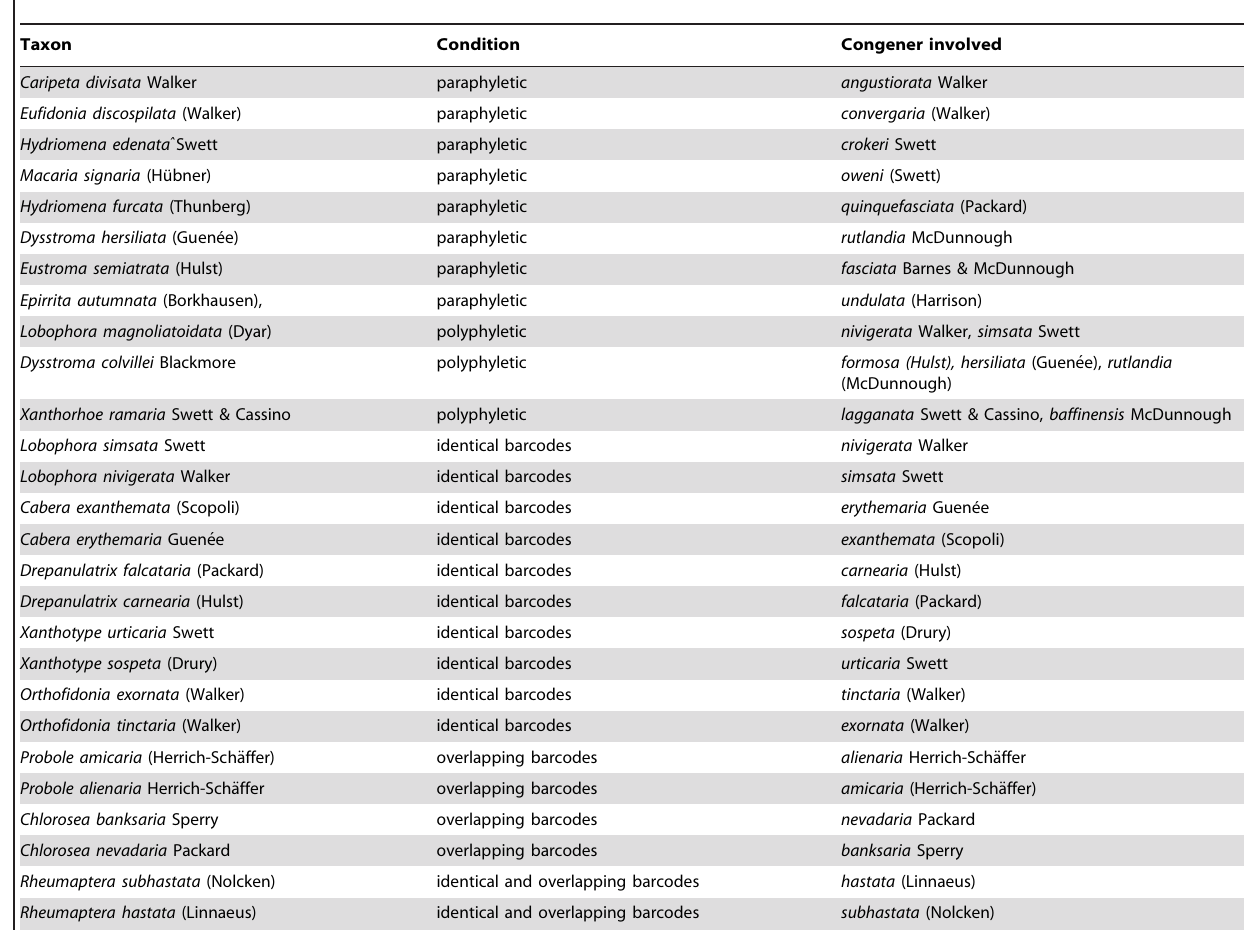
Table 1. Geometrid species not distinguishable by DNA